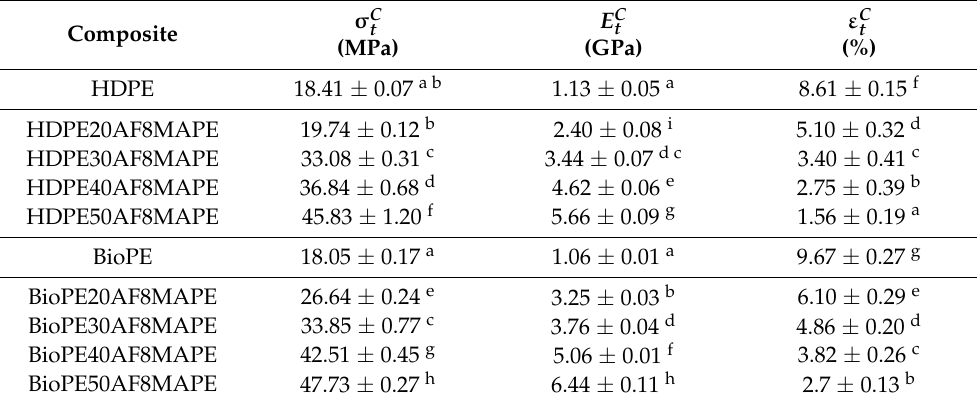
) of 8wt.% coupled t